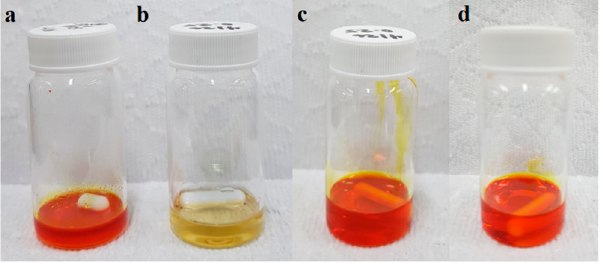
Figure 2. Polymer blend preparation from: ( a ) SDIB solution; ( b ) PBz solution; ( c ) Polymer Blend of SDIB/PBz (5/10 wt%); and ( d )Polymer blend of SDIB/PBz (10/10 wt%).